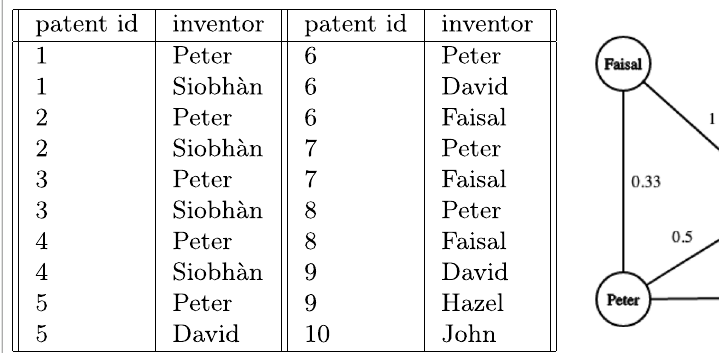
Fig. 3 Example Dataset and Resulting Graph Created by Algorithm 1